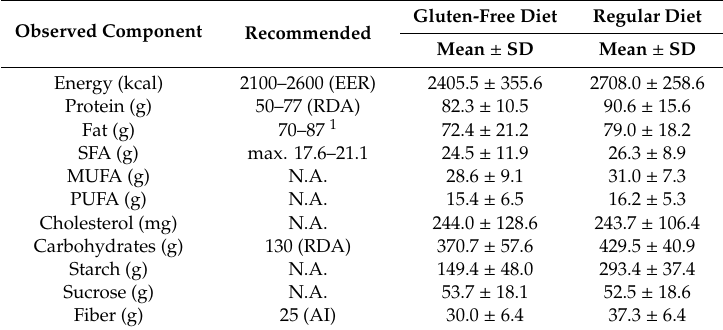
Table 1. Energy and macronutrients provided in prisons ( n = 10) menus per person per day and the age-specific dietary reference intake